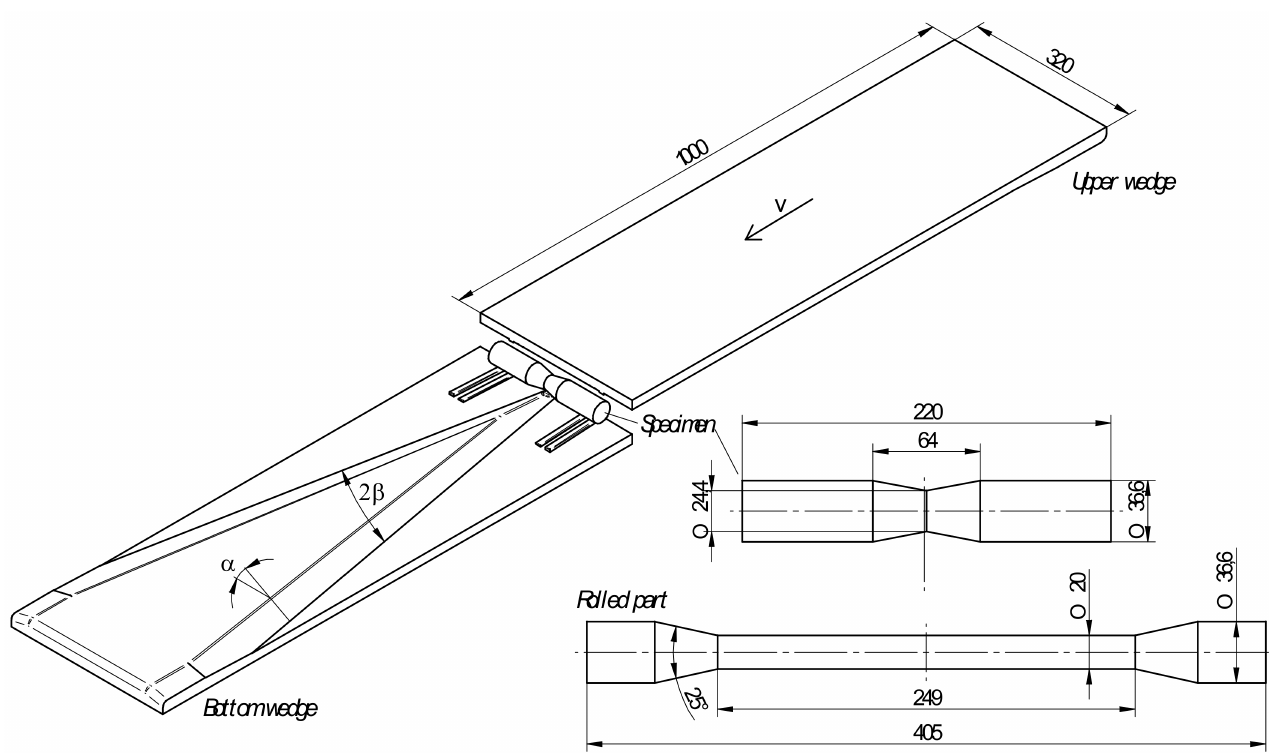
Figure 1. Schema of a new calibration test based on cross wedge rolling (CWR); dimensions in